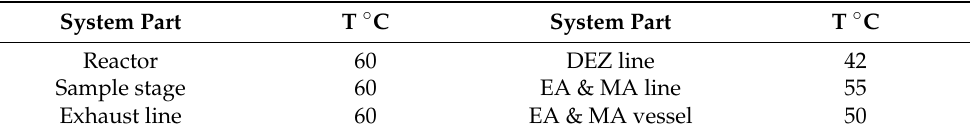
Figure 2. MLD setup scheme: Valve 1–3: ALD valves for precursor inlet control, valve 4–5: Magnetic valves for switching the Ar-flow, mass flow controller for setting 16 sccm Ar-flow, valve 6–7: Manual valves to de-/couple system and vacuum pump. Table 1. Heating temperatures of the MLD system reported in Figure 2.